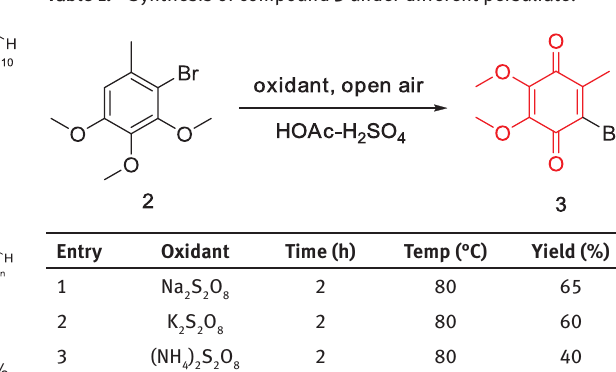
Table 1: Synthesis of compound 3 under different